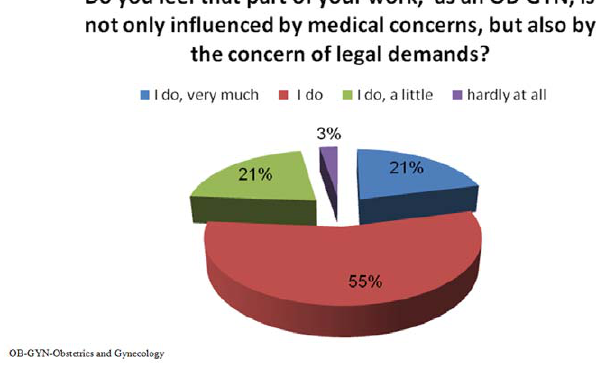
Figure 1. Concern regarding legal claims in the work of the OB- GYNs.